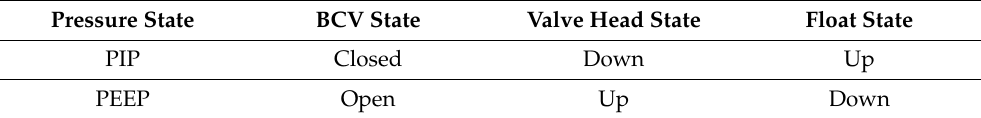
Table 1. The relationship between the pressure delivered and the states of key bubble vent Sub ‐ Assemblies and Parts.